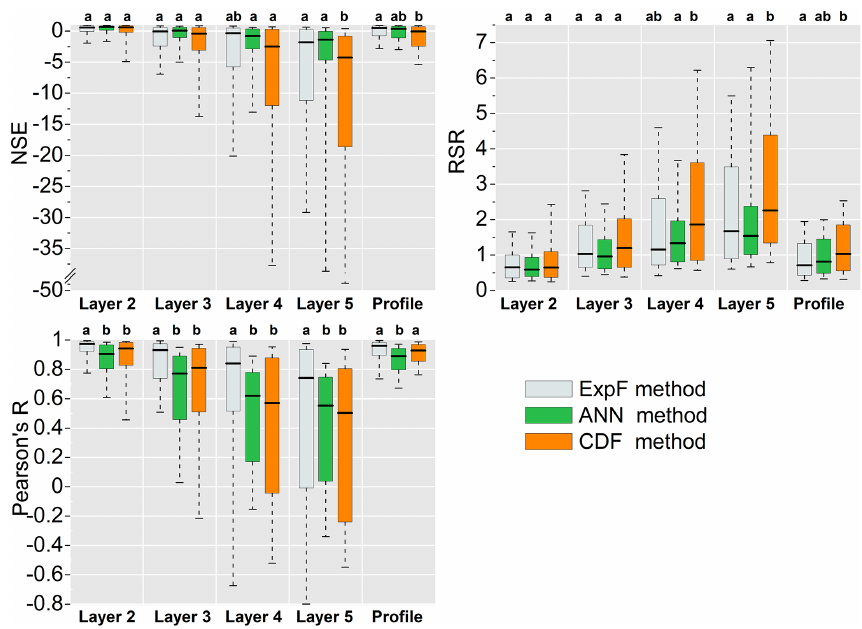
Figure 3. Boxplot of the metrics (NSE, RSR, R ) to compare the subsurface SM estimation using the surface SM by the three methods (ExpF, ANN, CDF) with the observations of the 35 stations during the growing seasons of 2014 to 2016. Different letters above the box indicate the significant difference ( p< 0 . 05) among the different methods. Table 2. The median of the performance (RSR, R , and NSE) of the three different methods (ExpF, ANN, and CDF) for estimating the subsurface SM using the surface SM for each layer of 35 stations during the growing seasons of 2014, 2015, and 2016. Layer RSR R NSE ExpF ANN CDF ExpF ANN CDF ExpF ANN CDF Layer 2 0.650 0.587 0.646 0.973 0.906 0.941 0.577 0.656 0.583 Layer 3 1.031 0.961 1.195 0.931 0.771 0.811 − 0 . 063 − 0 . 429 Layer 4 1.155 1.334 1.863 0.840 0.620 0.571 − 0 . 334 − 0 . 804 − 2 . 474 Layer 5 1.676 1.540 2.258 0.742 0.553 0.503 − 1 . 811 − 1 . 375 − 4 . 267 Profile 0.709 0.811 1.033 0.959 − 0 .